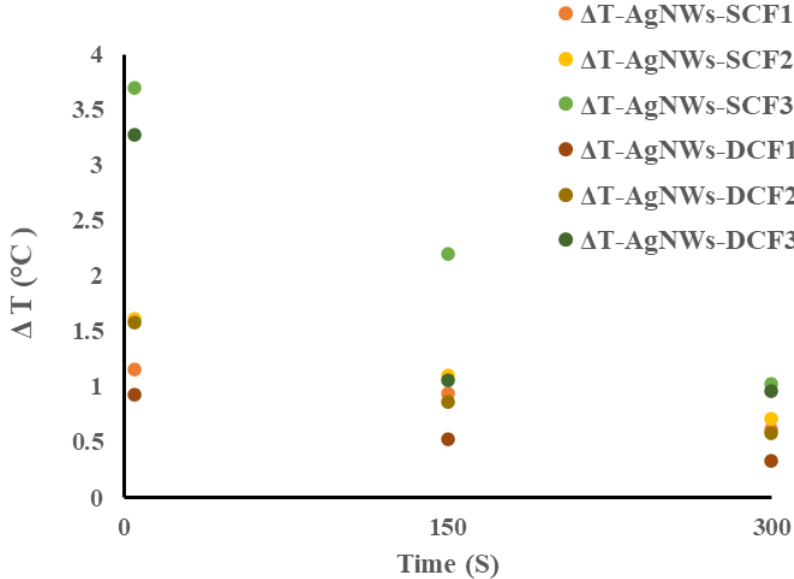
Figure 4. The temperature difference ( ∆ T) for each sample, including immersion and spray methods, as compared with the blank sample at the start, middle, and end times of the test interval.